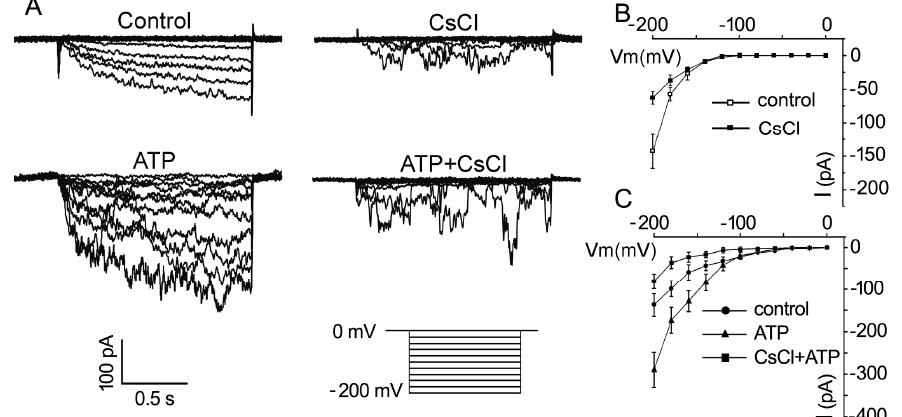
Figure 4. CsCl inhibits eATP-stimulated K + influx in the protoplasts of Arabidopsis pollen grains. ( A ) CsCl (1 mM) inhibited resting and 0.1 mM ATP-stimulated inward K + currents. Representative current traces from step-voltage clamping are shown. ( B , C ) I-V relationship curves of inward K + currents ( n = 7). In each experiment, data from 7 protoplasts were recorded and combined to obtain the mean ± SD.